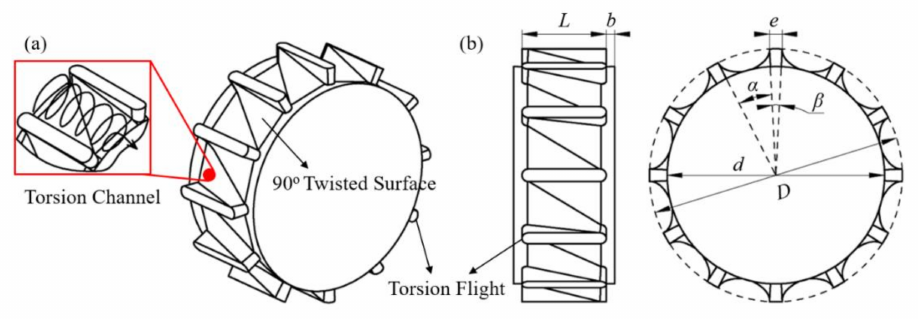
Figure 1. Three-dimensional model ( a ) and the characteristic dimensions ( b ) of the torsion